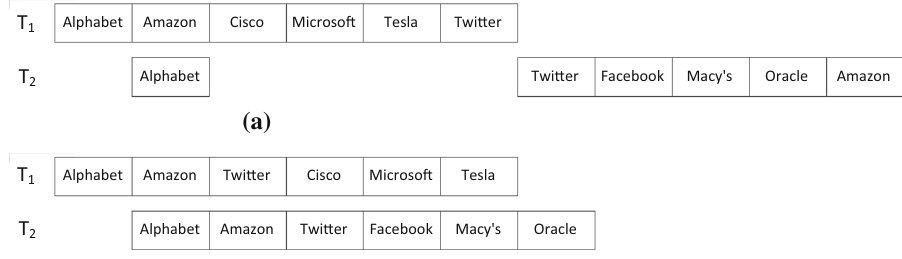
Fig. 1 Comparison of delay between original and